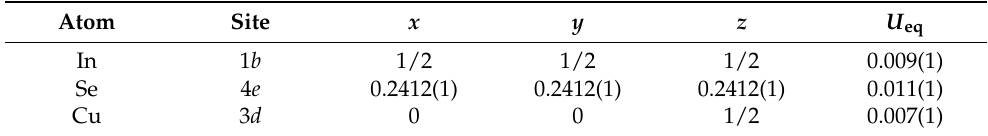
Table 2. Atomic coordinates and equivalent isotropic displacement parameters (Å 2 ). U eq is defined as one third of the trace of the orthogonalized U ij tensor.